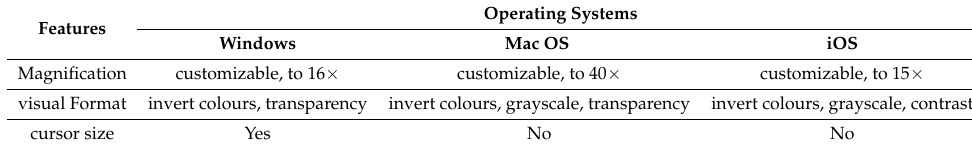
Table 13. OS and their features from [13].